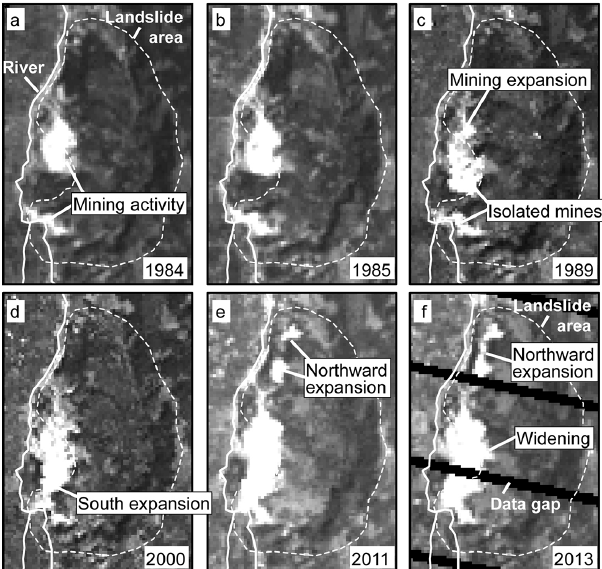
Fig. 2. Time series of Landsat images showing the development of the mining area. The spatial resolution of the images is 30m. These images emphasise the vegetation and the boundary between land and water. Bright colours indicate bare soil, which in this case is the mining area. Panels (d–f) show several expansions that have opened over the last 20